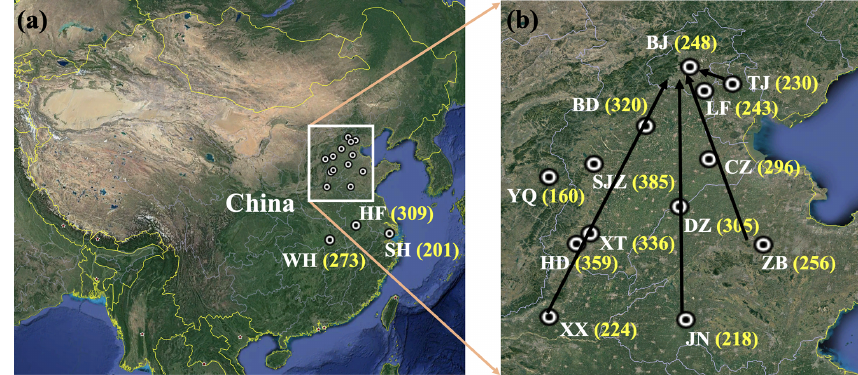
Figure 1. © Google Earth map of (a) China with the studied cities and (b) the North China Plain with all the lidar stations. The data in brackets are the maximum PM 2 . 5 concentrations (µgm − 3 ) at the surface during the observation period. The black arrows in (b) from left to right show that the main pollution pathways of Beijing come from the four directions of southwest, south, southeast, and